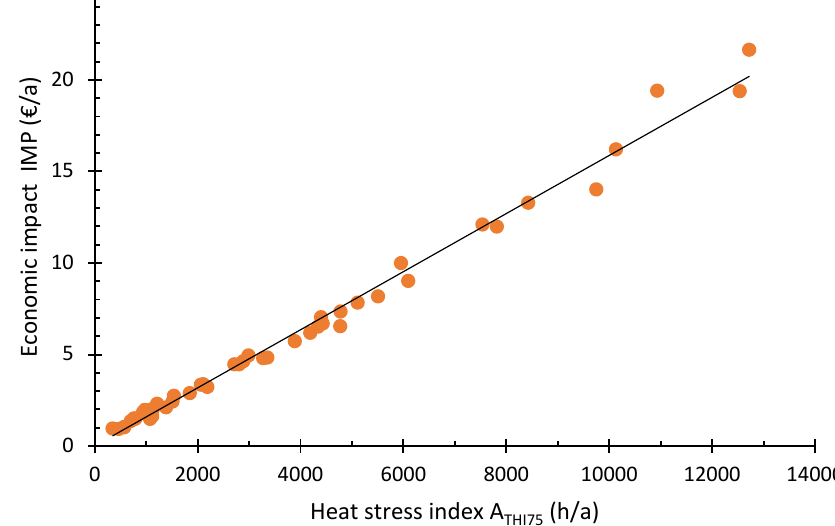
Figure 1. Economic impact IMP ( € /a per animal place), described by the reduction of the gross margin per animal place as a linear function of the heat stress index A THI75 (h/a) derived from St-Pierre, Cobanov and Schnitkey [36] with IMP = 0.0016 A THI75